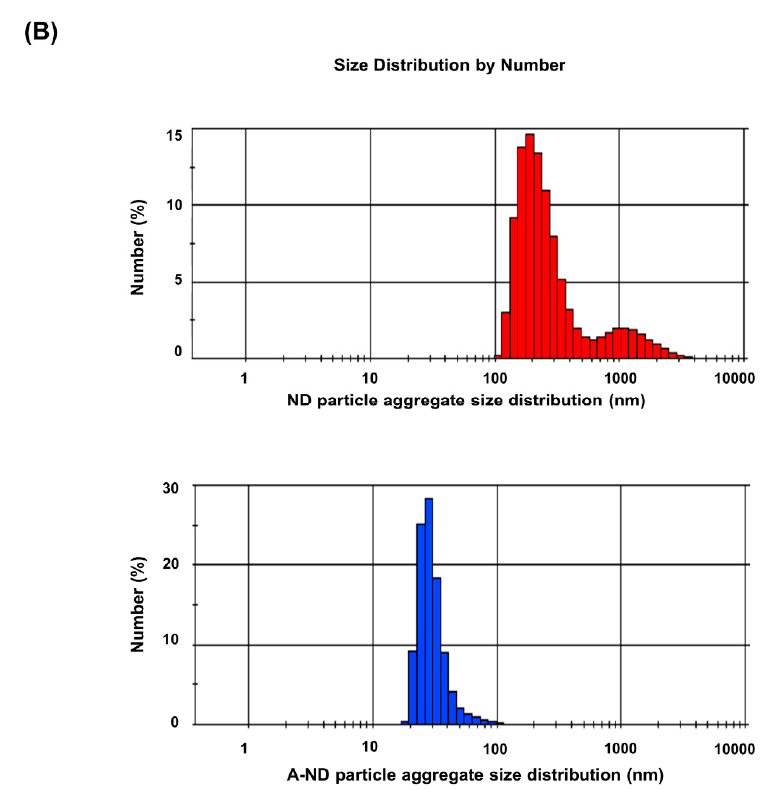
Figure 2. Characterization of nanodiamond particles. ( A ) TEM images of ND- and A-ND powder particles. ( B ) Histograms showing aggregate size evaluation. particles. ( B ) Histograms showing aggregate size